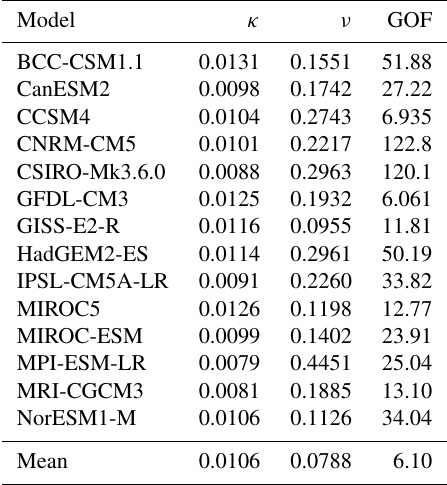
Table 2. Glacier sea level component calibration results with pa- rameter sets for the available CMIP5 models. Calibration parame- ters are introduced in Sect. 2.6. GOF is given as weighted RSS di- vided by the number of calibrated model years (weight glacier SLE contribution [mm]: 1). The optimal set for the mean response of the calibration data is given at the bottom of the